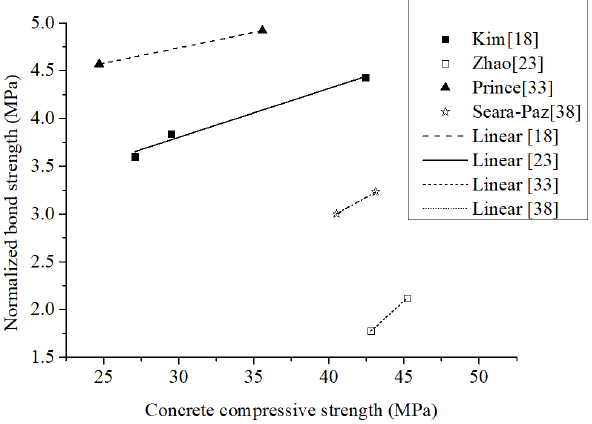
Figure 6: Normalized bond strength versus concrete compressive strength.